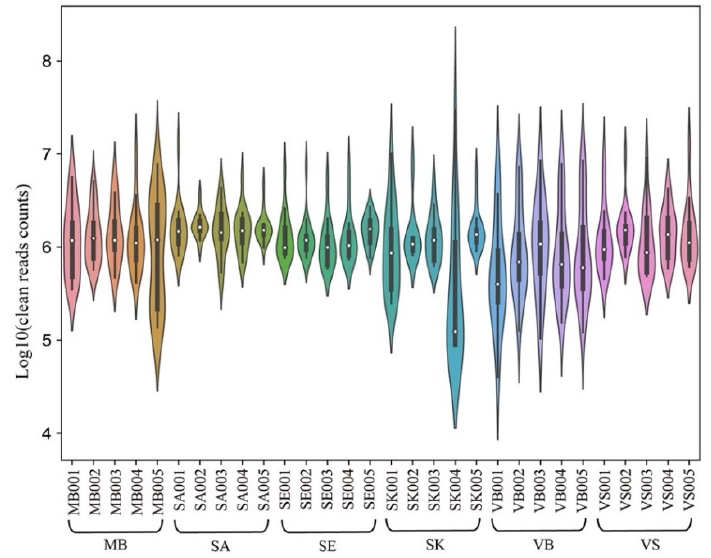
Figure 2. The counts distribution of the clean small RNA reads in five forensic body fluids and one skin tissue. Table 1. The quality and sequencing information of the different groups of samples.